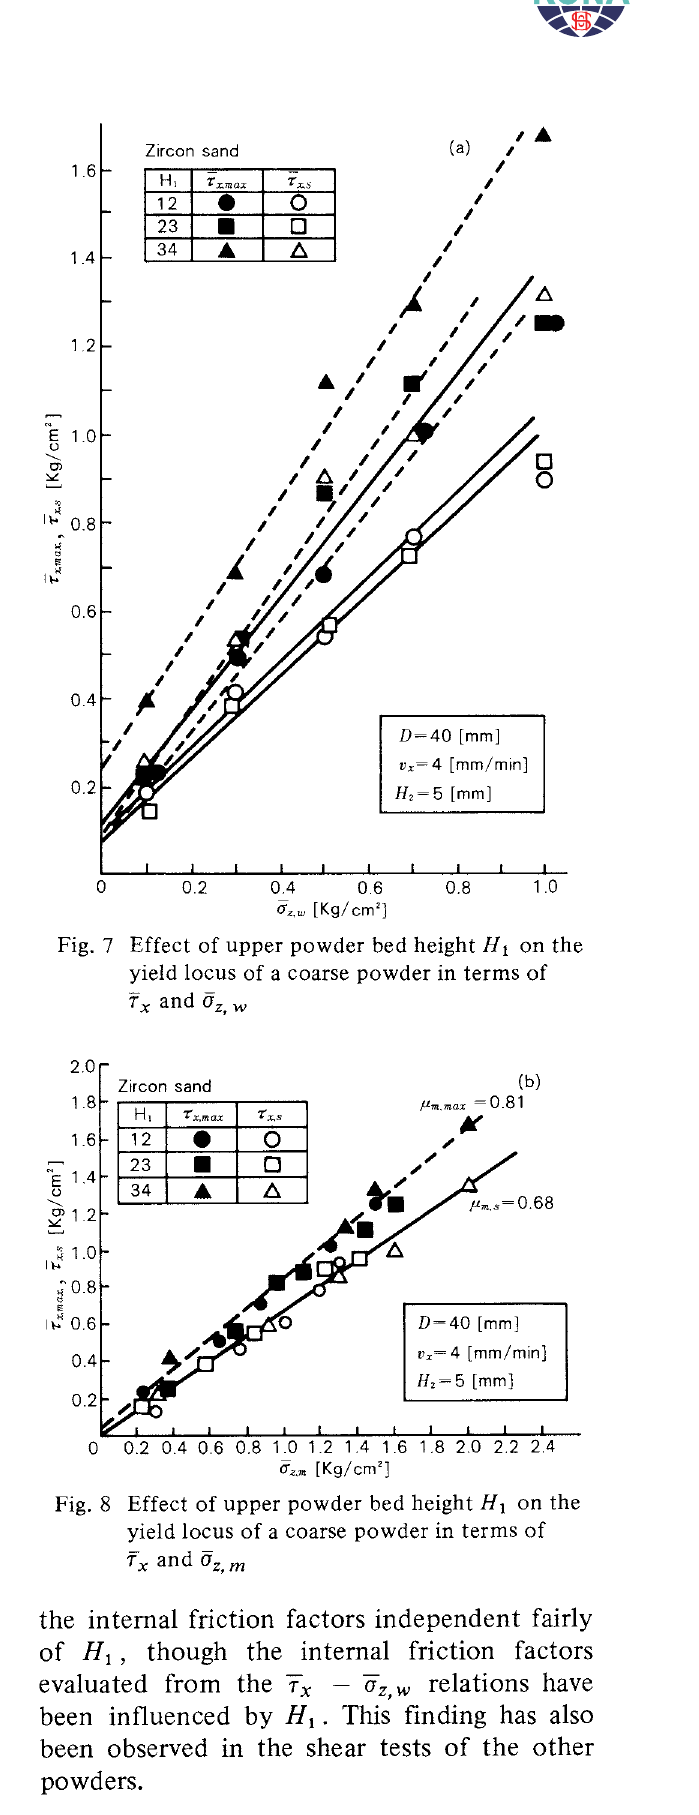
Fig. 8 Effect of upper powder bed height H 1 on the yield locus of a coarse powder in terms of Tx and